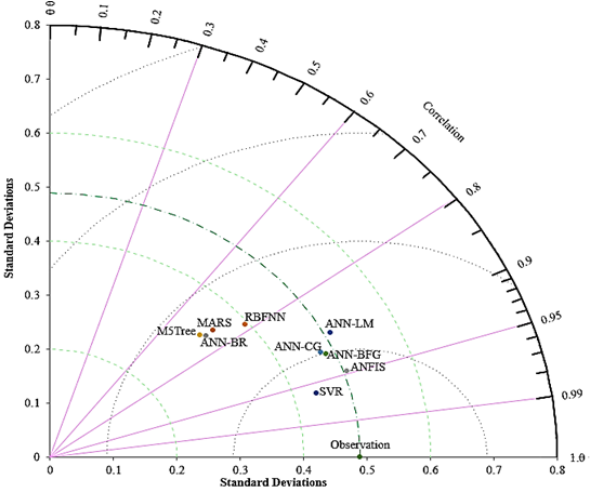
Figure 21. Taylor diagram for comparing the prediction capability of ML models; see abbreviations in Nomenclature.